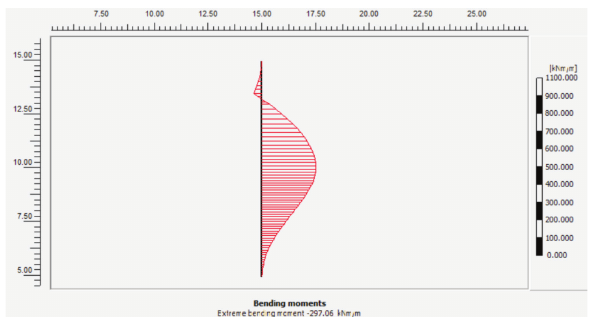
Figure 4: Maximum bending moment developed on wall panel as per EC 7(D1